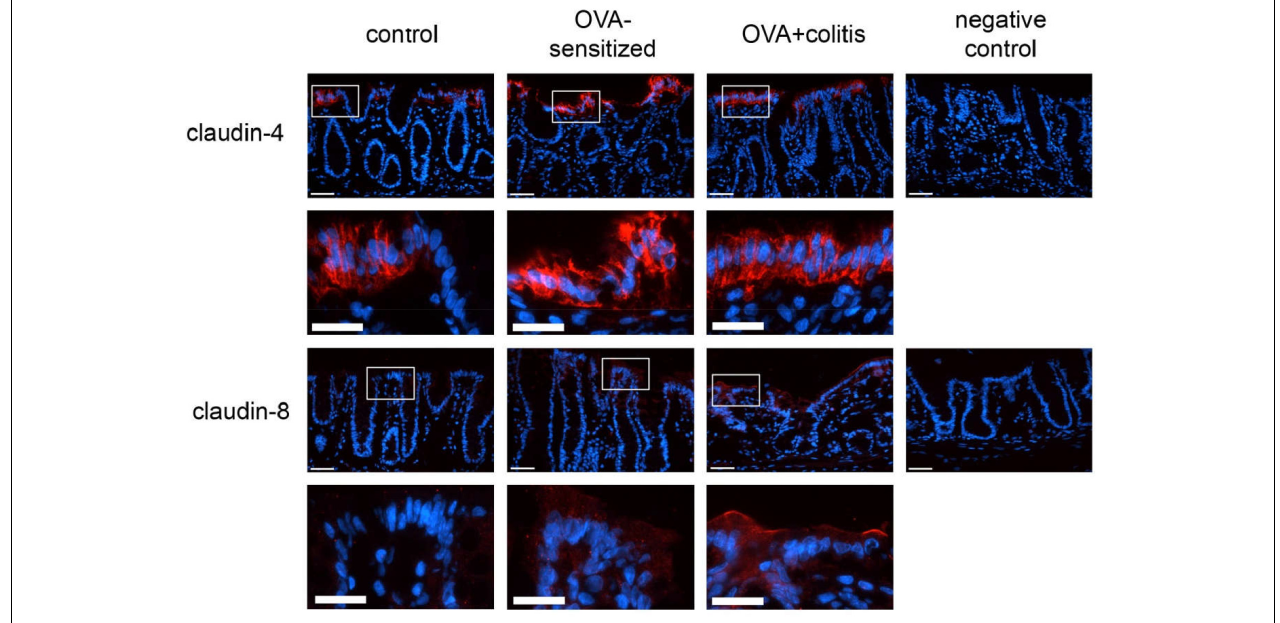
FIGURE 6 | Expression of claudin-4 (upper two rows) and claudin-8 (lower two rows) in rat colon under control conditions (1st column), in OVA-sensitized animals (2nd column), and in OVA+colitis animals (3rd column). The 4th column shows negative controls where the primary antibody against the respective claudin was omitted. Row 2 and 4 show enlargements of the pictures presented in the respective upper rows (with a rectangle depicting the localization of the magnifications). Thin calibration bar (1st and 3rd row): 50 µ m; thick calibration bar (2nd and 4th row): 25 µ m. Representative staining of three independent experiments for each claudin type.